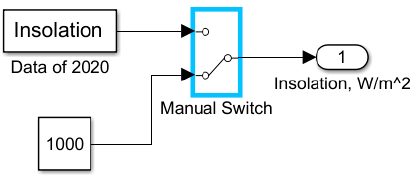
10 of 19 Figure 12. Hydrogen production and pumping for fuel cell operation. 2.2.6. Final Photovoltaic Powered Hydrogen Simulink Model The complete model of the photovoltaic powered hydrogen generation system in Matlab/Simulink is presented by the following chart, Figure 13. Figure 13. The complete model of the photovoltaic powered hydrogen generation system in Matlab/Simulink.